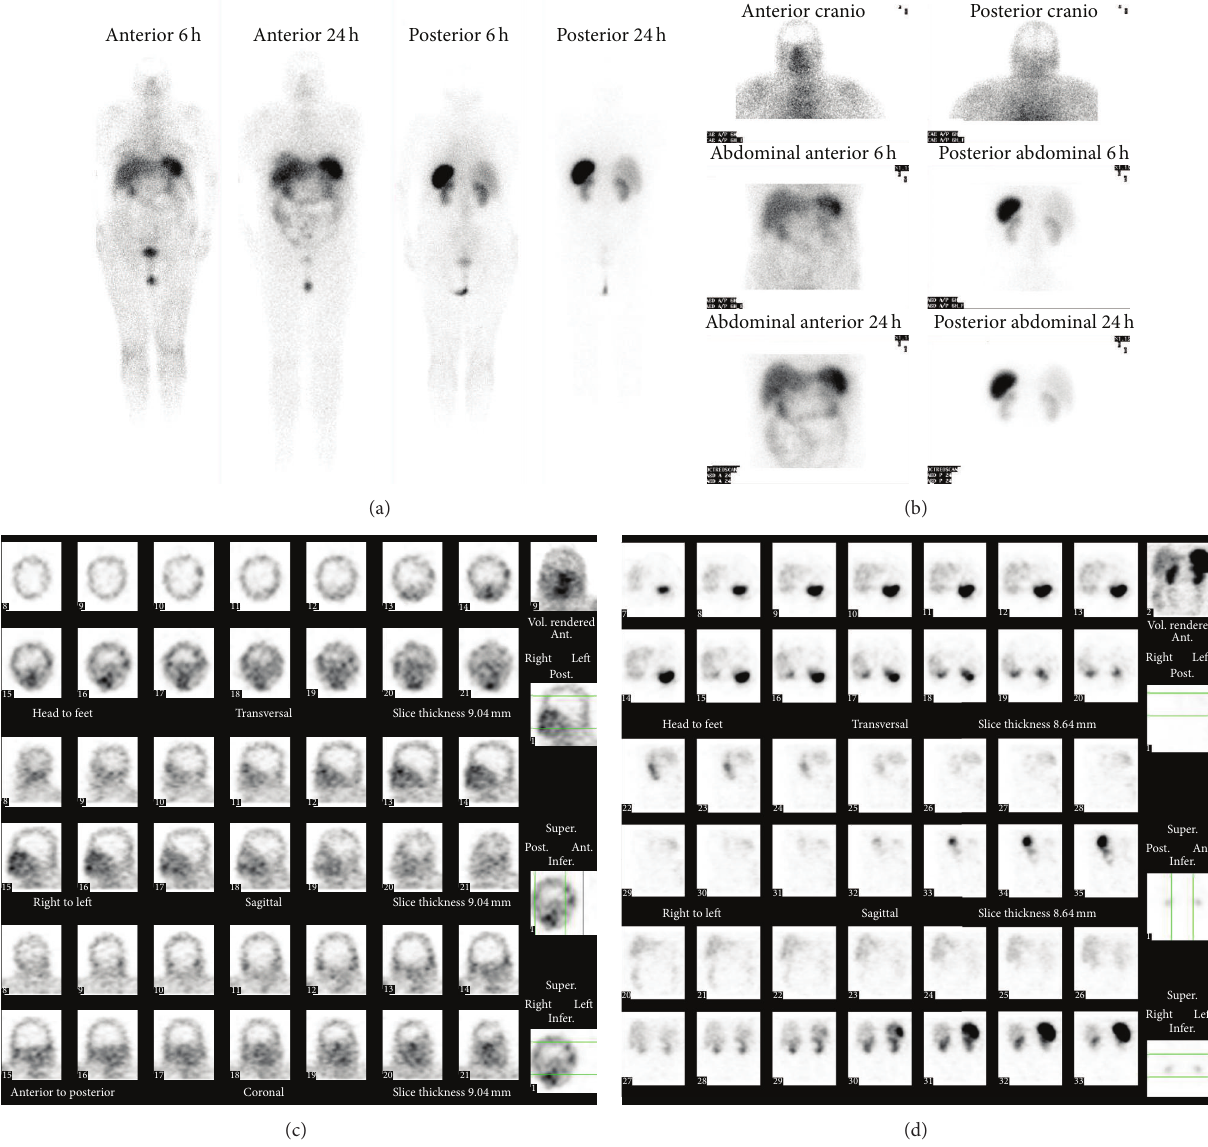
Figure 3: Somatostatin receptor scintigraphy ( 111